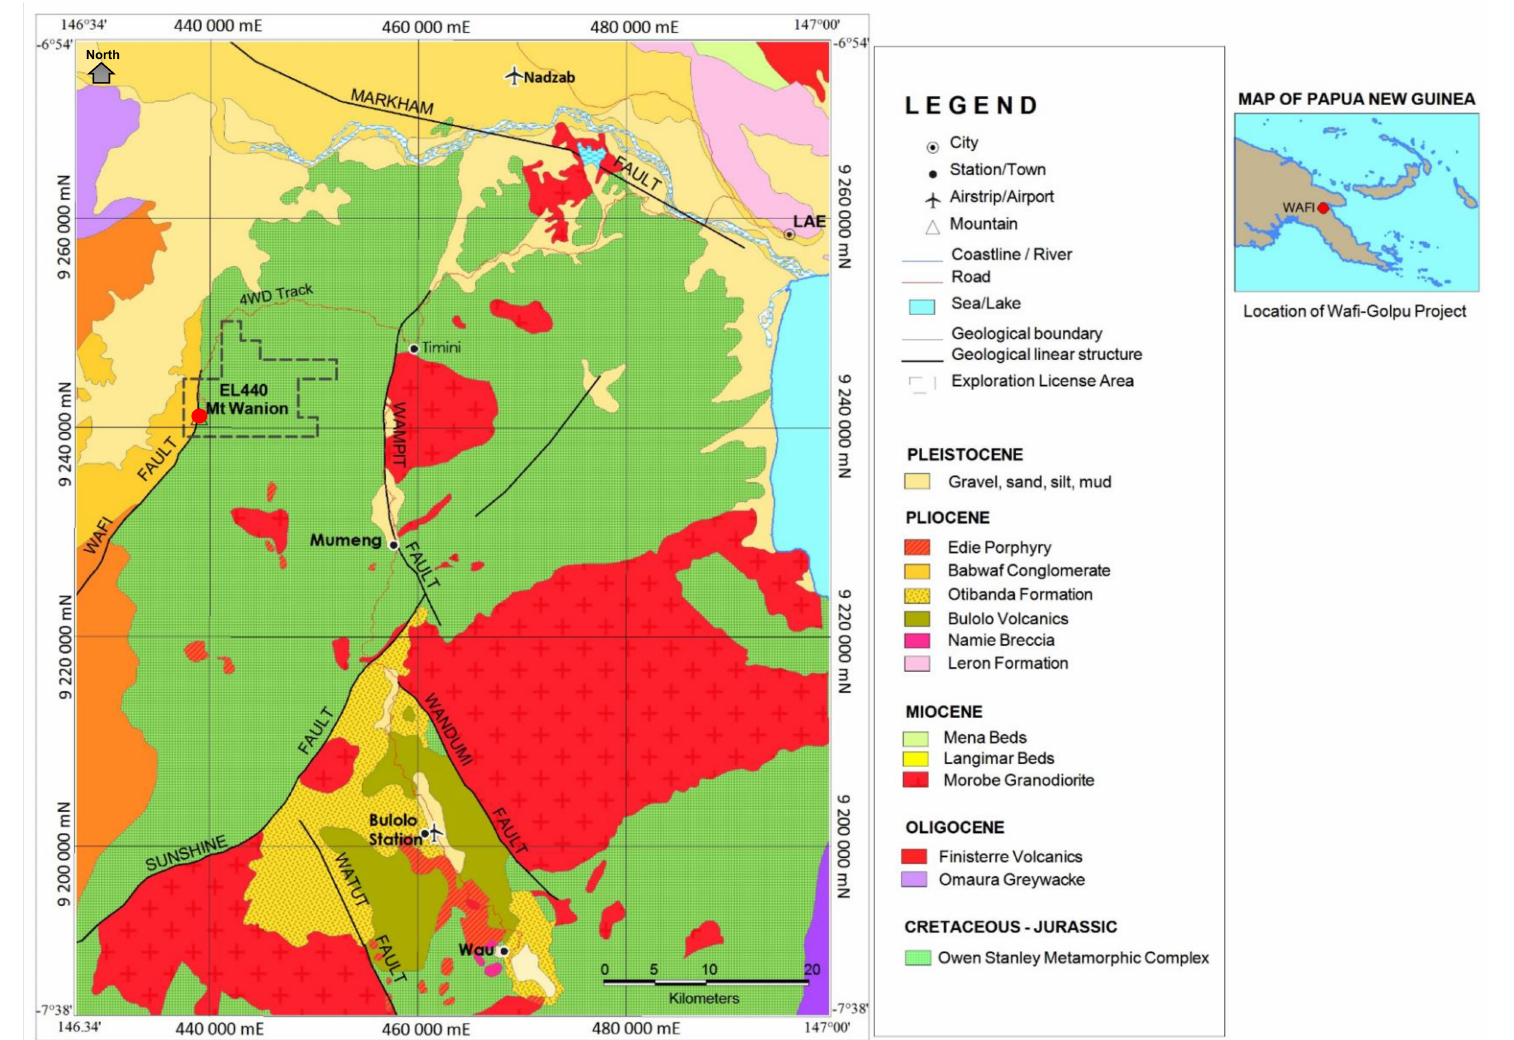
Figure 2. Regional geology of the Bulolo-Wau area, Morobe Province, Papua New Guinea (Lunge, 2013). Red dot in EL440 Mt Wanion indicates the location of the